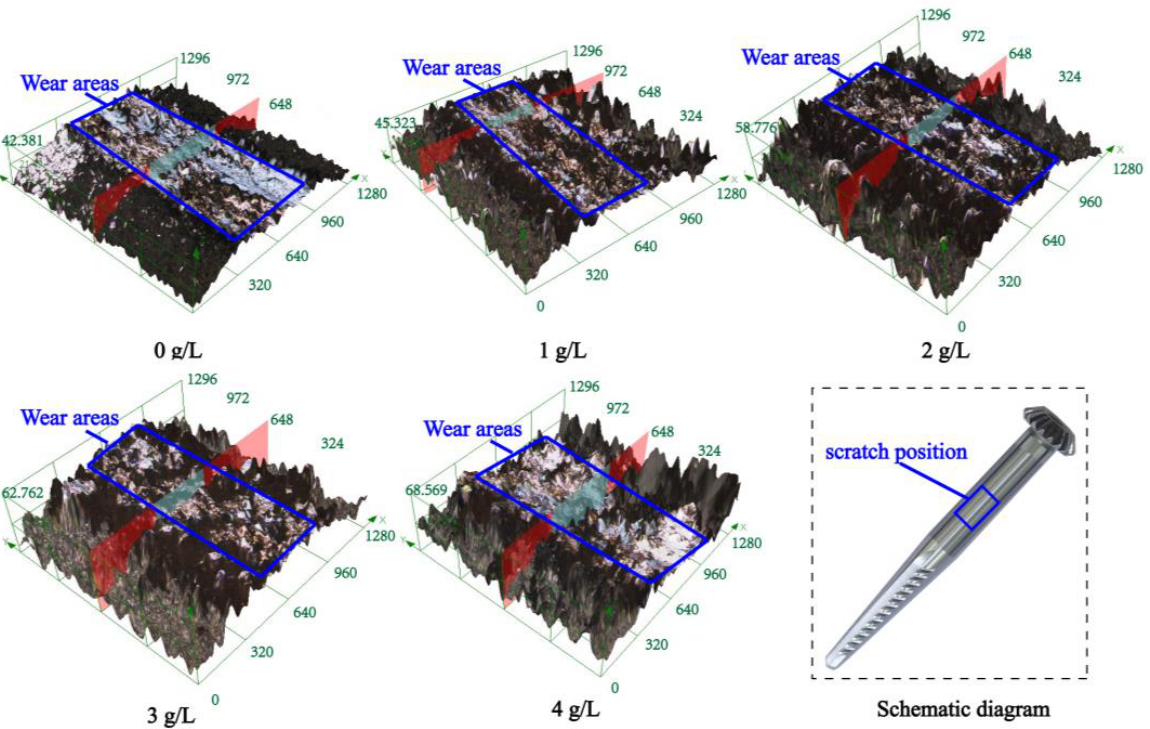
Table 4. Section p arameters of wear scars on the composite coating with different β -SiC concentra- tions.